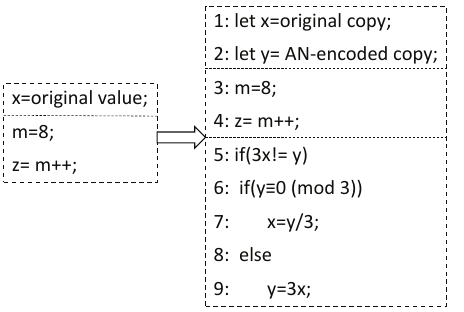
Figure 1. A pseudo-code of duplication-based